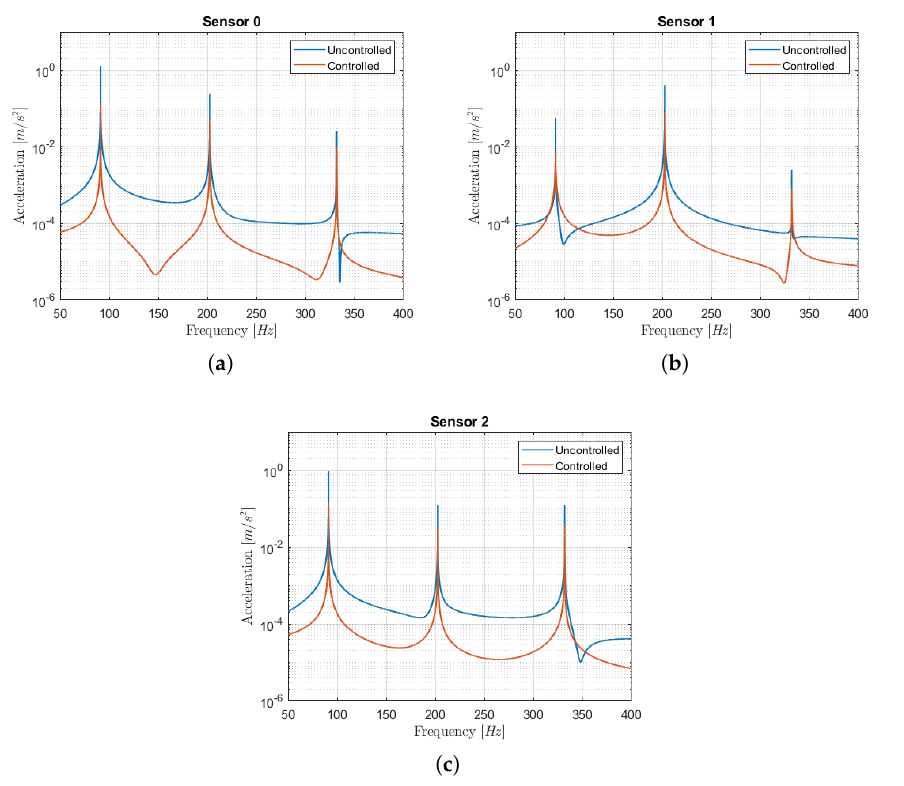
Figure 5. Comparison between the vibration of the uncontrolled (blue line) and controlled (red line) system on the three sensors locations in numerical simulation.